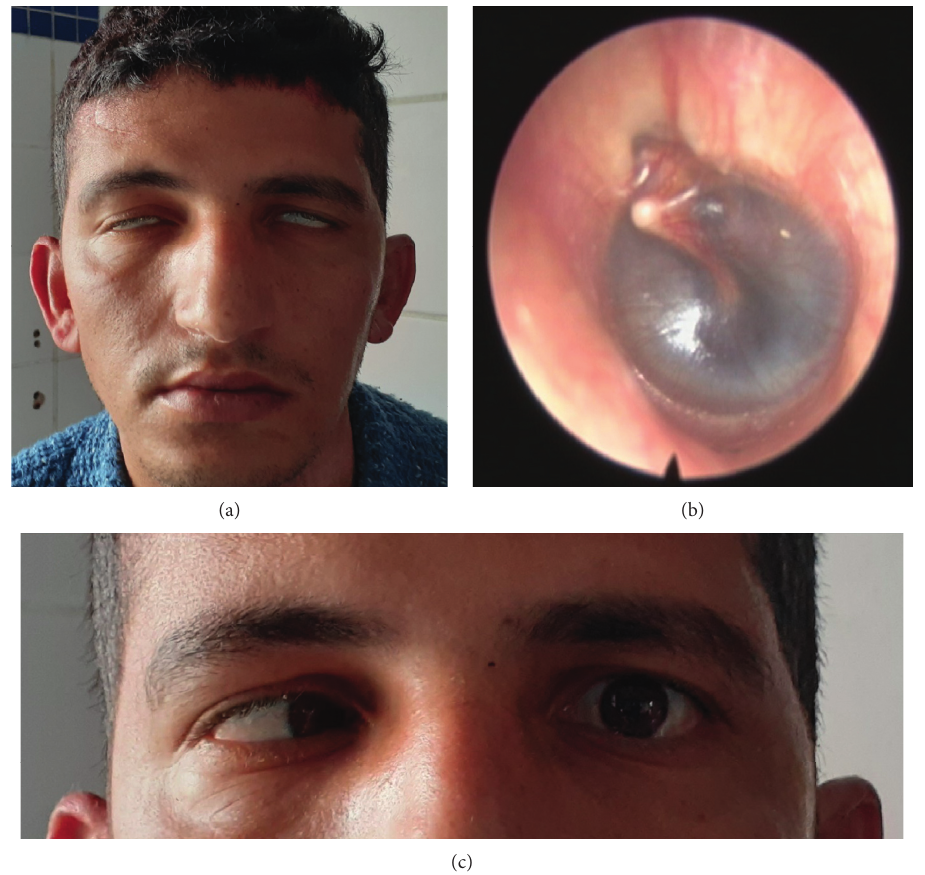
Figure 1: (a) Bilateral Charles Bell’s phenomenon with mask-like face. (b) Left ear hemotympanum. (c) Left abducens palsy.